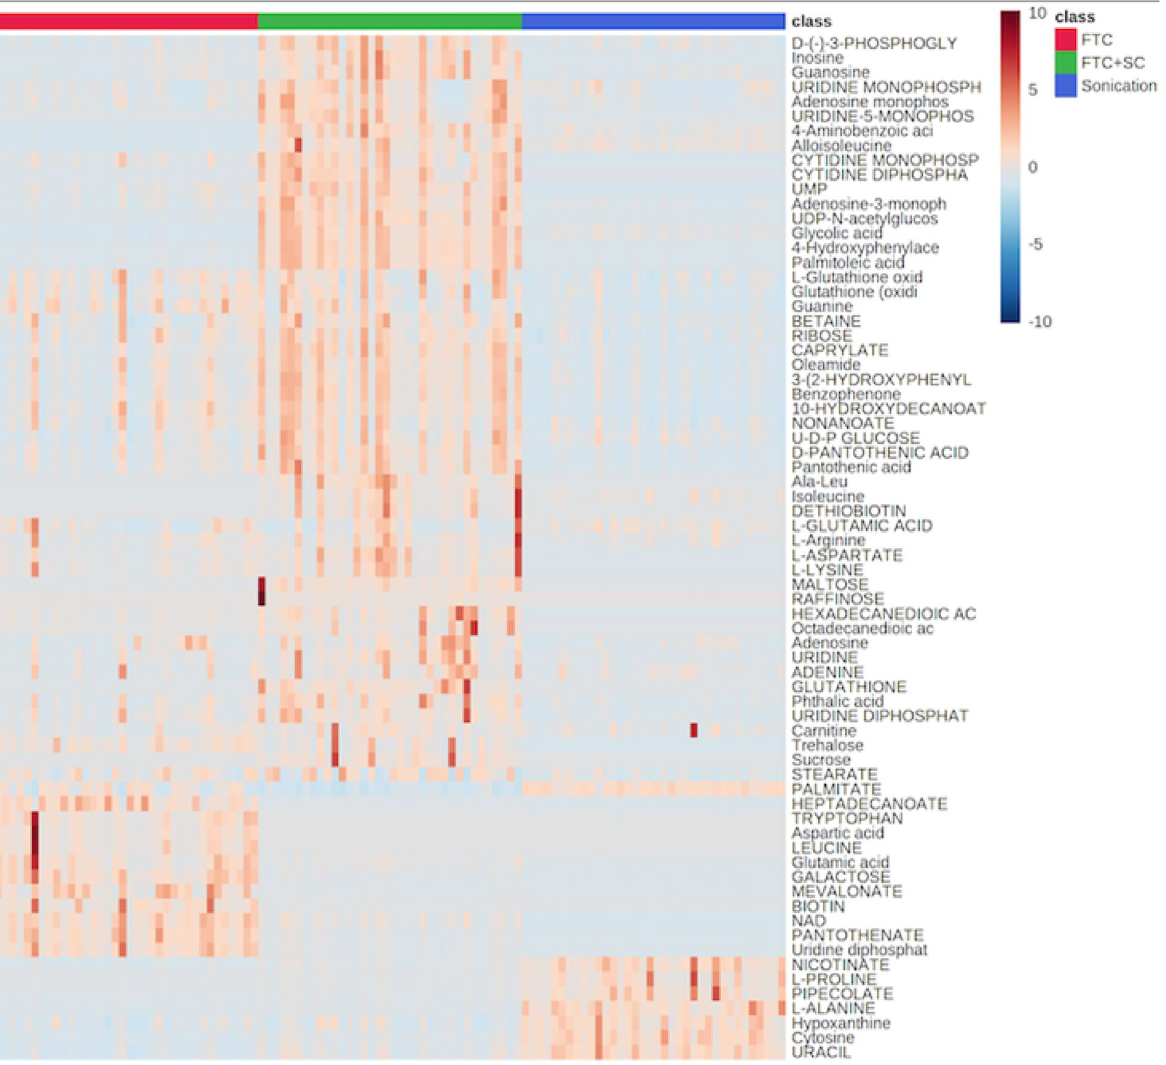
Figure 4. Heat map displaying qualitative enrichment occurred in the AMR associated metabolites. Red FTC, Green FTC + SC, Blue Sonication